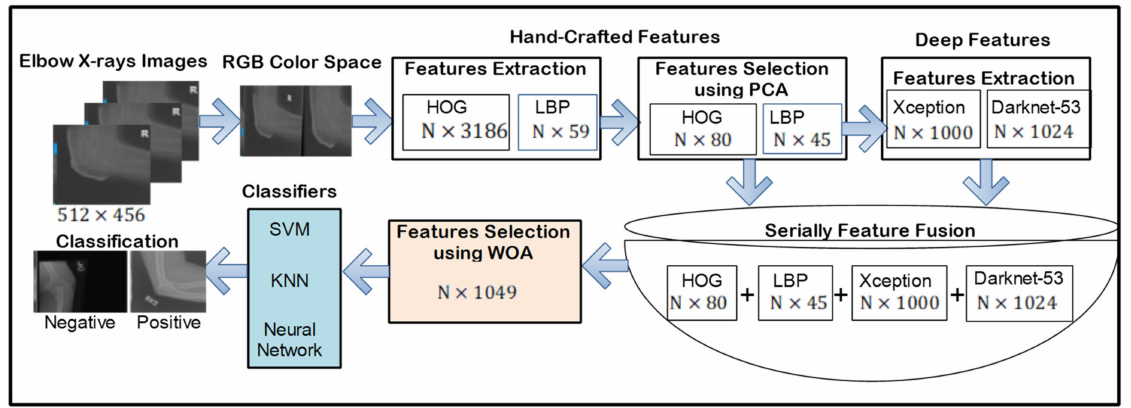
Figure 1. Proposed model for classification of the fractured elbow using X-ray